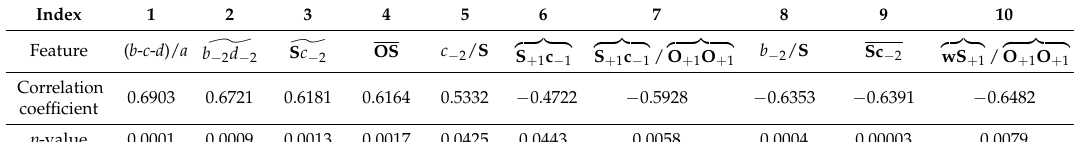
Table 1. A correlation coefficient list of top 10 features with systolic blood pressure (SBP).